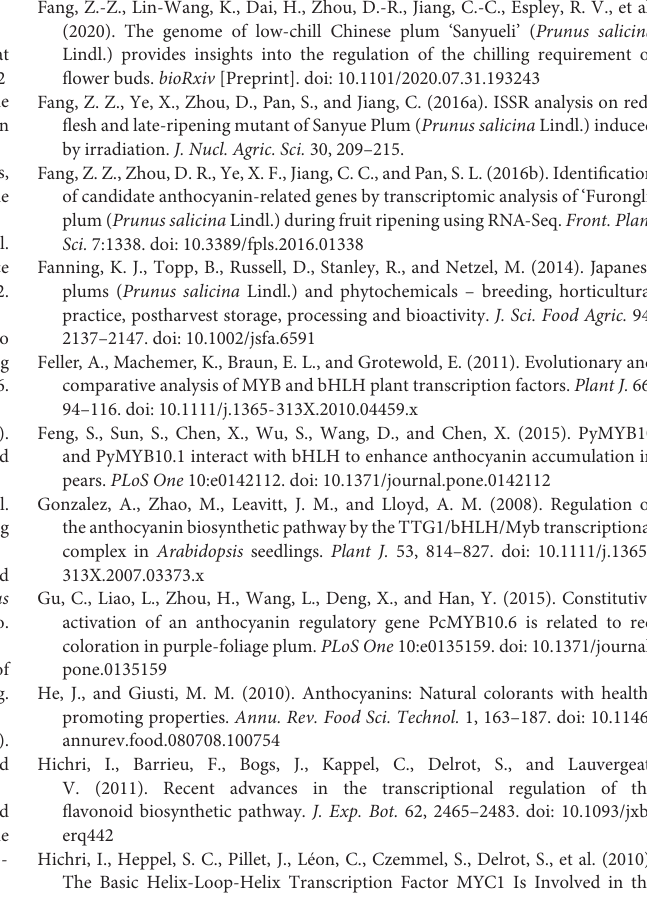
Supplementary Figure 1 | Heat map of correlation coefficients between samples. Supplementary Figure 2 | Differentially expressed genes (DEG) identified by RNA-seq analysis in the flesh of ‘Sanyueli’ and the mutant. (A) DEGs of different comparison groups. (B) Venn diagram showing the number of differentially expressed genes. SY indicates DEGs during ripening of ‘Sanyueli’, MT indicates DEGs during ripening of the red-fleshed mutant, SY vs. MT indicates DEGs between ‘Sanyueli’ and its red-fleshed mutant. Supplementary Figure 3 | Nucleotide alignment of the coding sequence of PsSY0021637, PsSY0023440, PsSY0011279, and PsSY0011777. Supplementary Figure 4 | Gene structure of PsSY0021637, PsSY0023440, PsSY0011279, and PsSY0011777. (A) Schematic overview of introns and exons in PsSY0021637, PsSY0023440, PsSY0011279, and PsSY0011777. (B) Structural alignments of PsSY0011279 and PsSY0011777. Boxes and lines represent exons and introns, respectively. Supplementary Table 1 | Primer sequences for qRT-PCR analysis. Supplementary Table 2 | Sequences of primers used for vector construction. Supplementary Table 3 | Summary of sequencing and mapping results. Supplementary Table 4 | Summary of functional annotations for putative new genes.